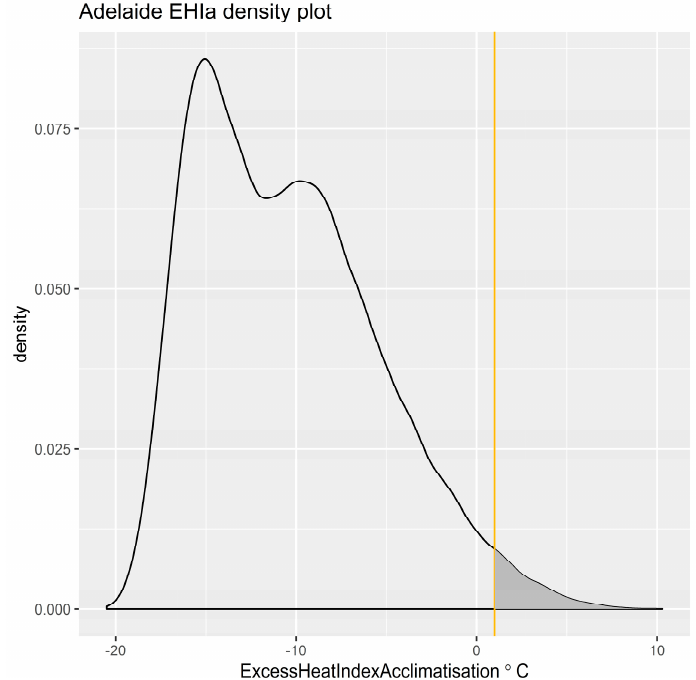
Figure A3. Distribution function of EHI accl for 1960 to 2018 climate period. Shaded region >1 shows acclimatization distribution samples when calculating EHF.